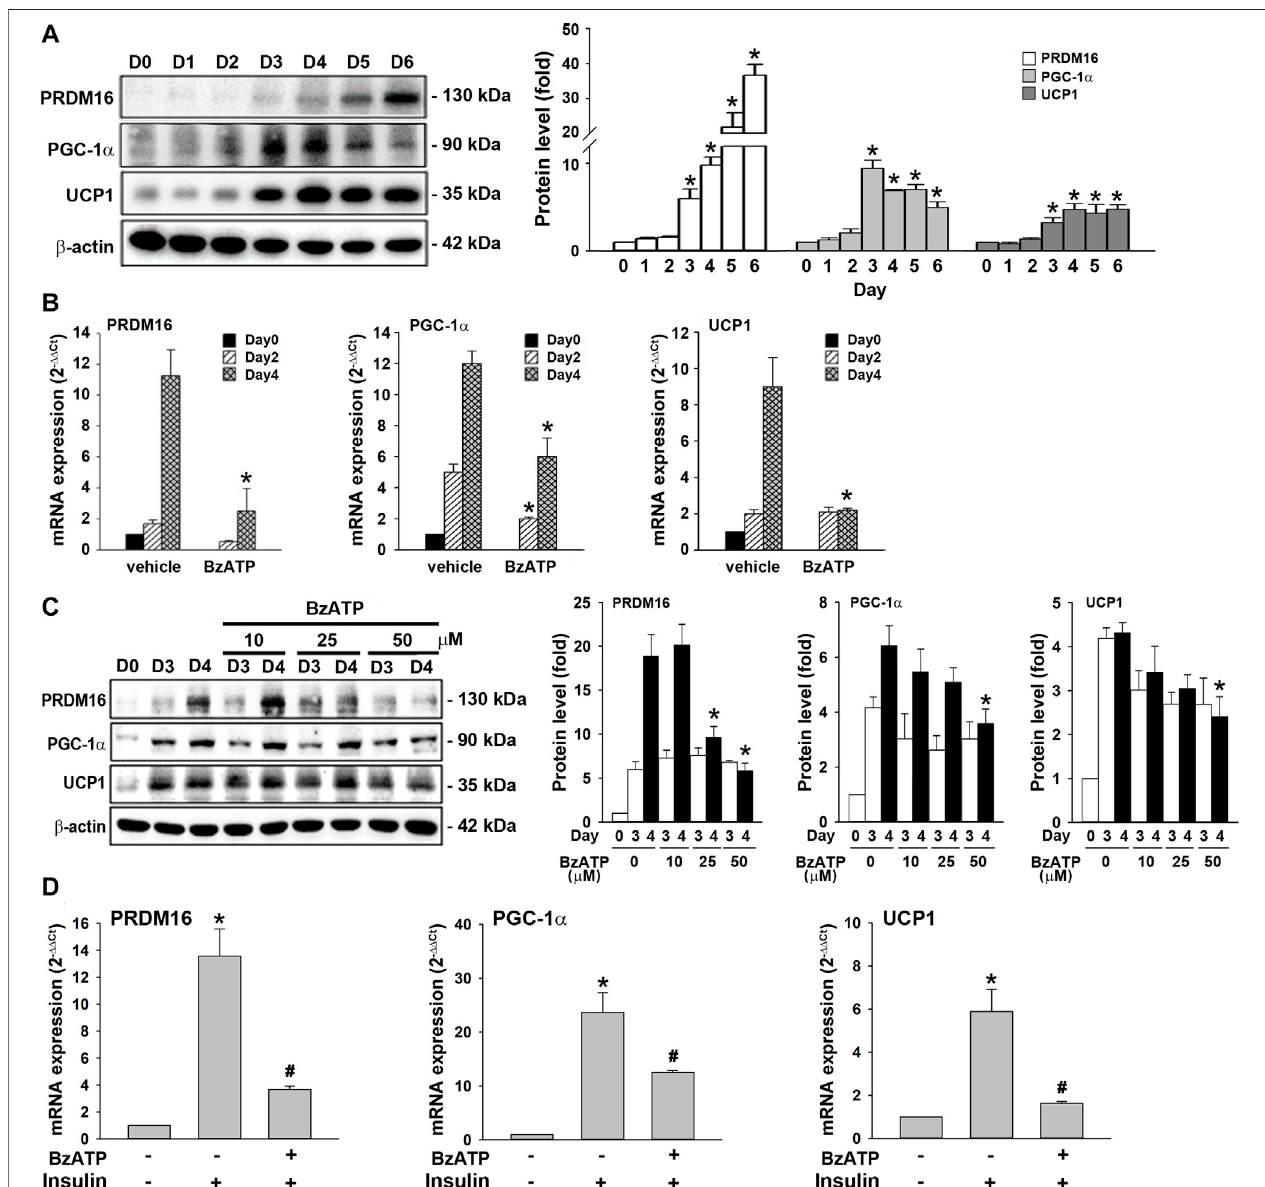
FIGURE 5 | P2X7 activation downregulates the expression of PRDM16, PGC-1 α , and UCP1 genes during adipocyte differentiation. (A) Western blot analysis of browningmarkerPRDM16,PGC-1 α ,andUCP1duringadipocytedifferentiationwithquanti fi cationbynormalizingto β -actin.* p < 0.05 vs .preadipocytesatD0. (B) Cells weretreatedwithBzATP(50 μ M)atD0andagainattheendofD2upontherenewalofthedifferentiationmedia.ThemRNAlevelsof PRDM16 , PGC-1 α ,and UCP1 atD0, D2,andD4weremeasuredbyqPCR.* p < 0.05vs.vehicle-treatedadipocytesatD2orD4. (C)